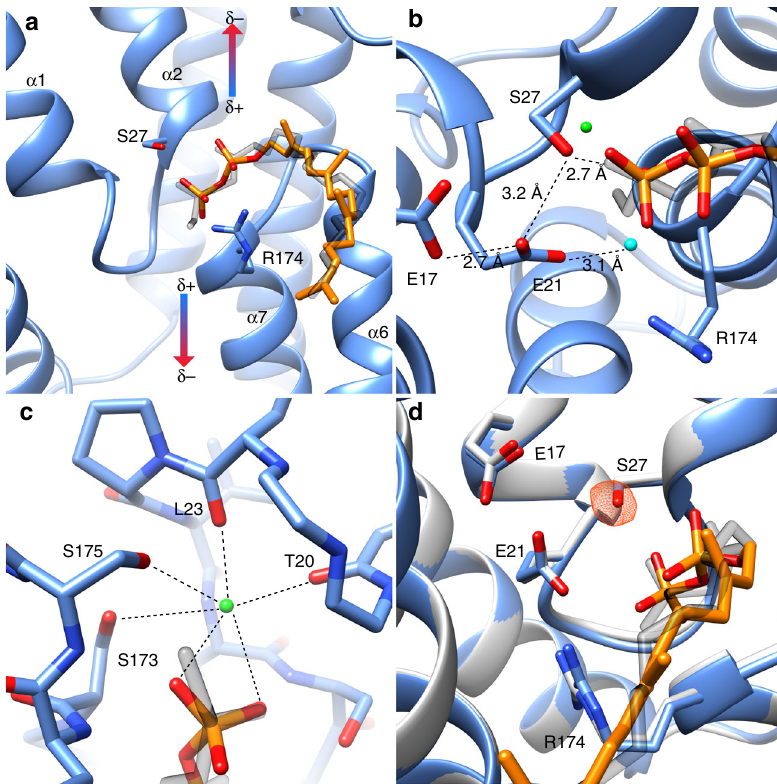
Fig. 4 Modeling of C55-PP in the Ec UppP active site a . Overlay of the C55-PP pyrophosphate on the observed monoolein headgroup illustrates the coordination of the pyrophosphate by the N termini of α 2 and α 7. b Overlay of the C55-PP on the observed monoolein headgroup highlighting the interaction network of the key catalytic residues Ser27 (nucleophile), Glu21 (base), Glu17 (carboxyl – carboxylate pair), Arg174 (coordinates beta- phosphate). c Observed coordination sphere of a bound water we propose may represent a potential binding site for the requisite catalytic cation. The overlaid pyrophosphate would contribute two ligands and a favorable electronegative stabilization to the bound metal. d Overlay of wild-type (blue) and S27A mutant (gray) crystal structures show that the active site architecture is not perturbed by the S27A mutation. To con fi rm the identity the S27A mutant, the wild-type model was re fi ned against the S27A data and an mF o -DF c map was calculated to show the negative difference peak for the Ser27 side chain hydroxyl (contoured at 3 σ